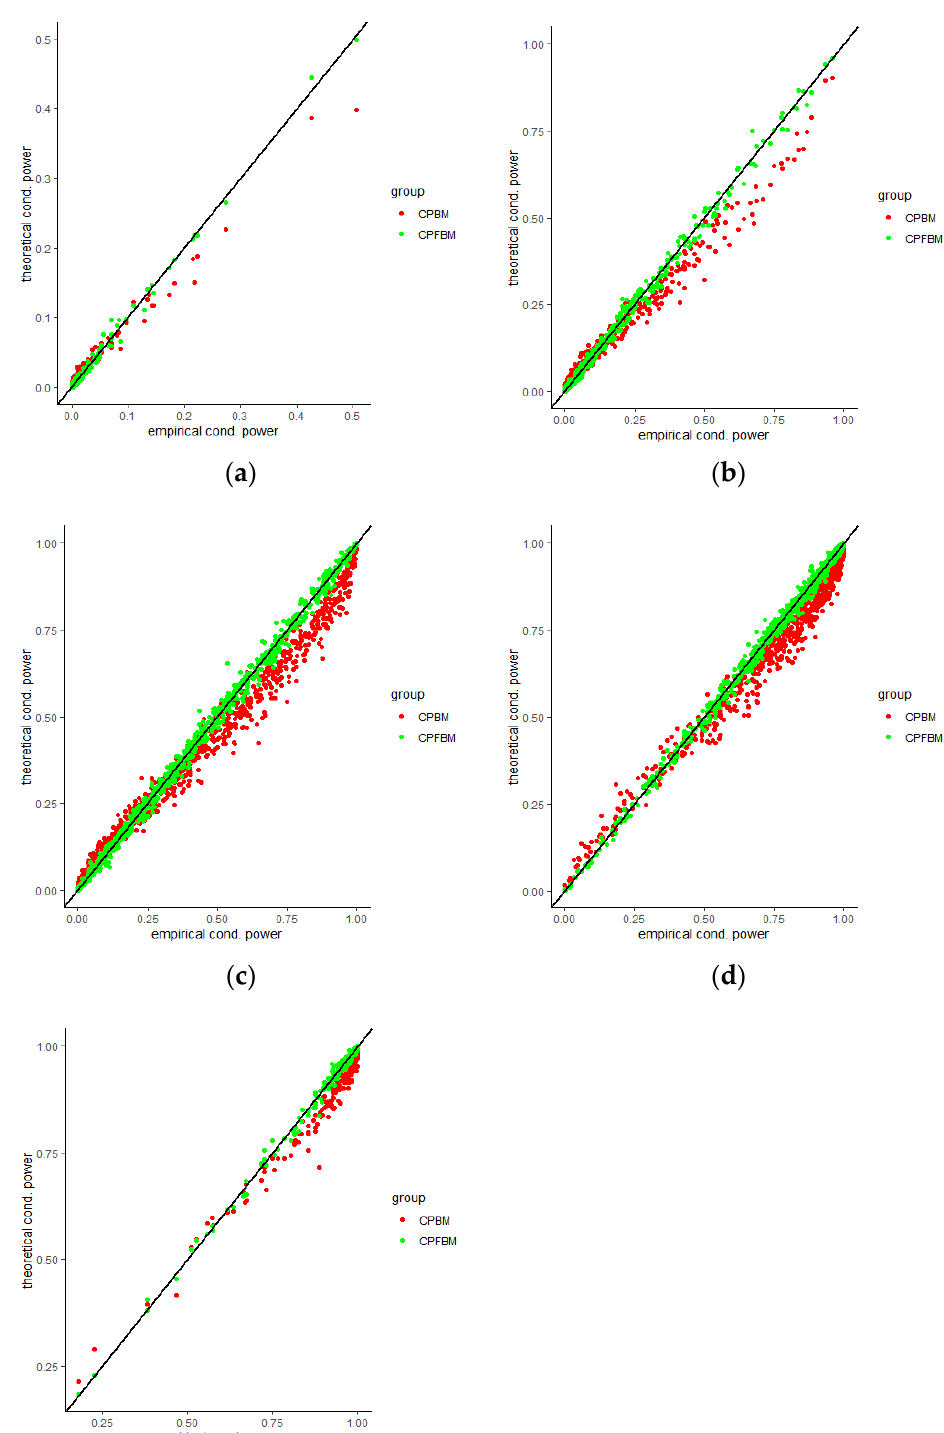
Figure 7. Scatter plots for conditional power under misspecification scenarios (PS design) showing no covariates with different drift parameters 𝜃 : ( a ) 𝜃 = 0; ( b ) 𝜃 = 0.5; ( c ) 𝜃 = 1; ( d ) 𝜃 = 1.5; ( e ) 𝜃 = 2.